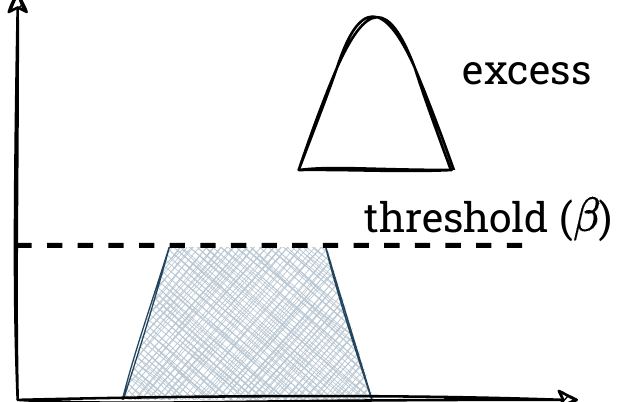
Figure 4. First step of the redistribution procedure: calculation of excess.